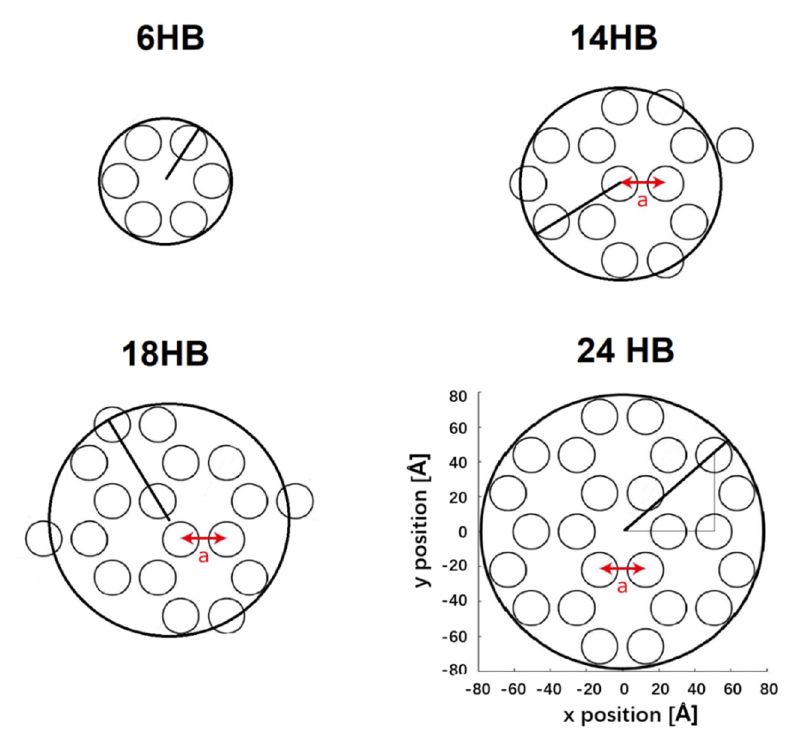
Figure A1. Cross section of DNA origami structure with 6HB, 14Hb, 18HB and 24HB; inter helical distance is a = 2.6 nm calculated with a DNA double strand radius of r = 1 nm and an inter-helical gap of 0.6 nm; Model of 6HB with a radius of R 6HB = a + r, 14HB with a radius of R 14HB = √3 a + r, 18HB with a radius of R 18HB = ( √3 + 1/2 ) a + r, 24HB with a radius of R 24HB = √7 a + r. After assembly, 1LS, 2LS, 24HB, 18HB and 14HB origami nano-rods were purified by spin